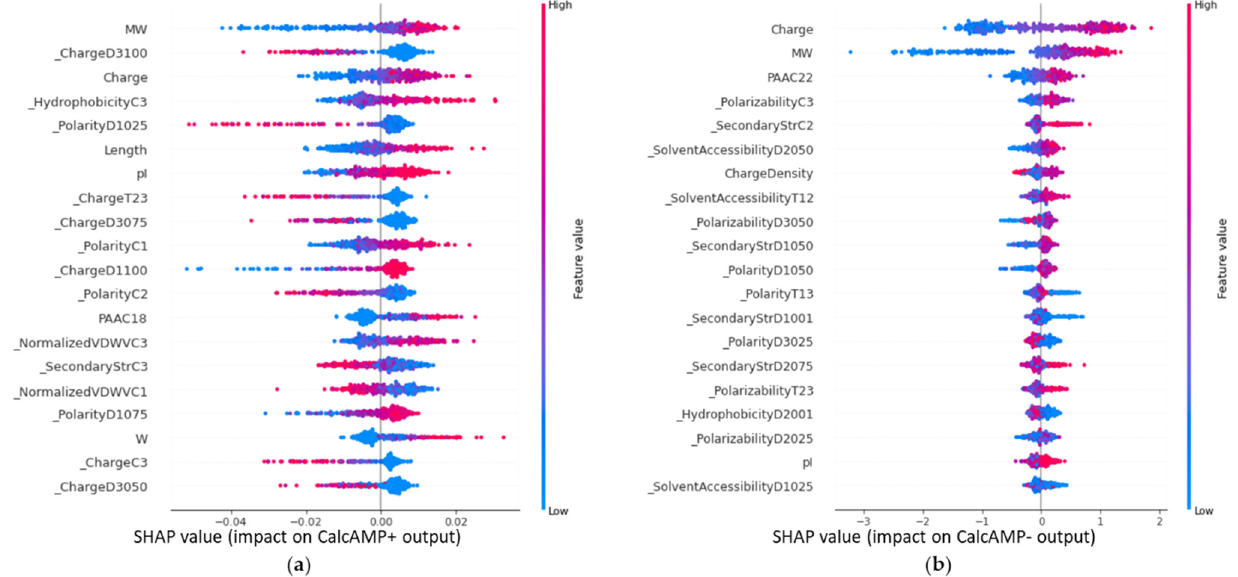
Figure 6. Top 20 features importance plot and their impact on the external test set prediction for CalcAMP+ ( a ) and CalcAMP- ( b ). Shown are physicochemical properties such as molecular weight (MW), Charge, or Length. However, the majority of the top features were from CTD descriptors. They are identifiable by their names beginning with an underscore character, followed by the property and fi nally the component characteristics: composition (C), transition (T), and distribution (D).